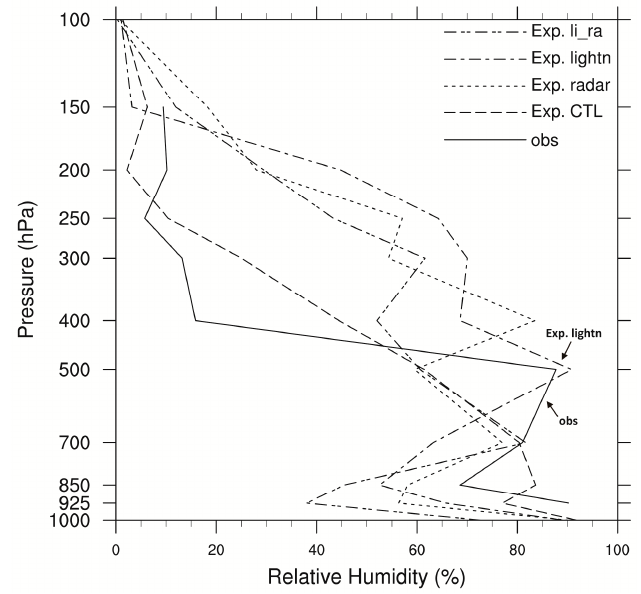
Figure 12. Relative humidity profile forobservations, Exp. CTL, Exp. radar, Exp. lightn and Exp. li_ra at Beijing, 1200 UTC.